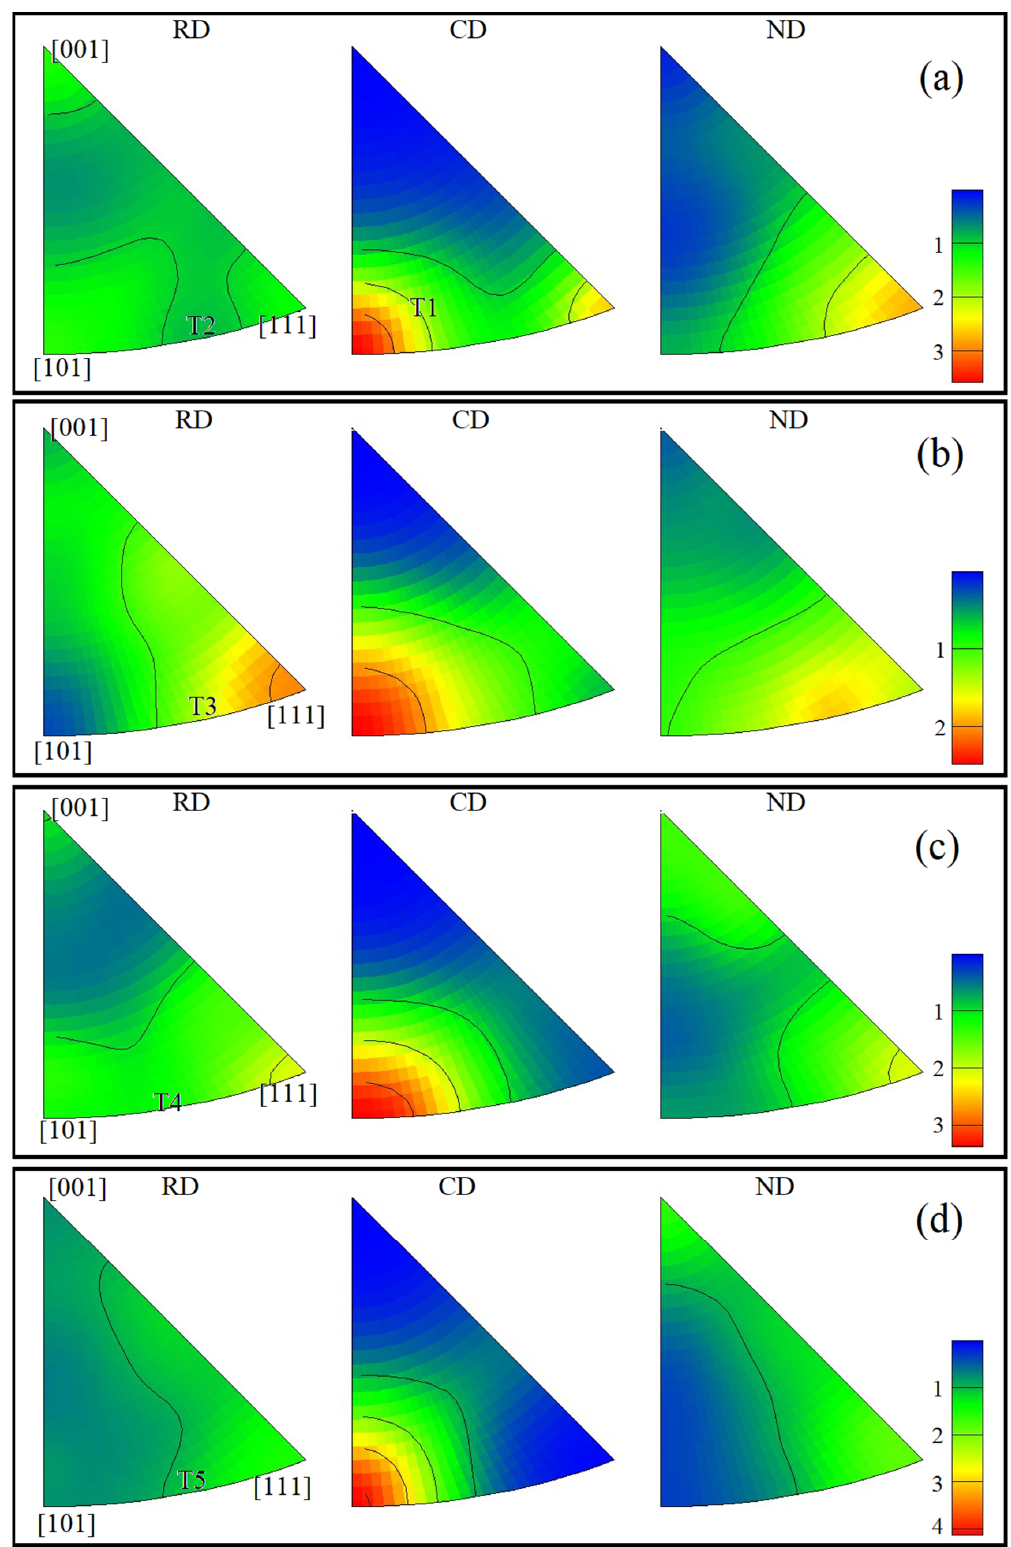
Figure 6. Inverse pole figures of the Cu-Sn-P alloy at different temperatures: ( a ) 200 °C, ( b ) 300 °C, ( c ) 400 °C, and ( d ) 500 °C. In the figure: radial direction (RD), compression direction (CD), and normal direction (ND).